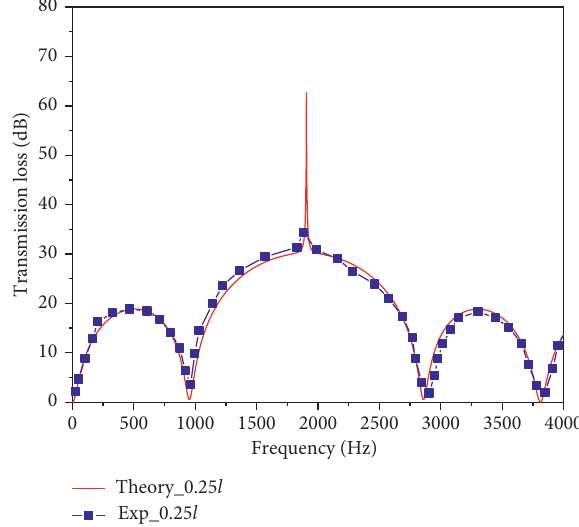
Figure 14: Comparison of the theoretical and experimental results of the transmission loss of the muffler (0.25 l ).